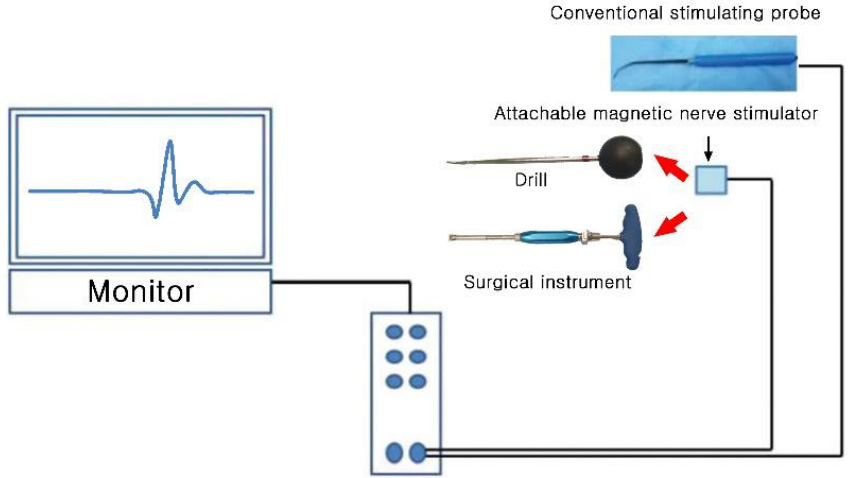
Figure 2. Schematic diagram comparing conventional probe and novel magnetic probe. The conventional probe is integrated with the wire, whereas the magnetic probe has the stimulator part replaced with a magnet and could be attached to other surgical instruments. In contrast, the wire carrying the electrical signal is the same for both probes. A subperiosteal approach was adopted posteriorly until the lamina, facet joint, and transverse processes on both sides of the fourth and fifth lumbar vertebrae were